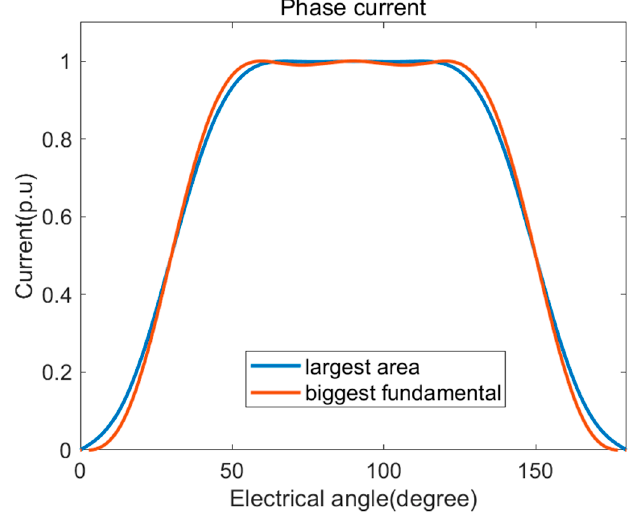
Figure 2. Current optimized for fifth + seventh-harmonic current injection.